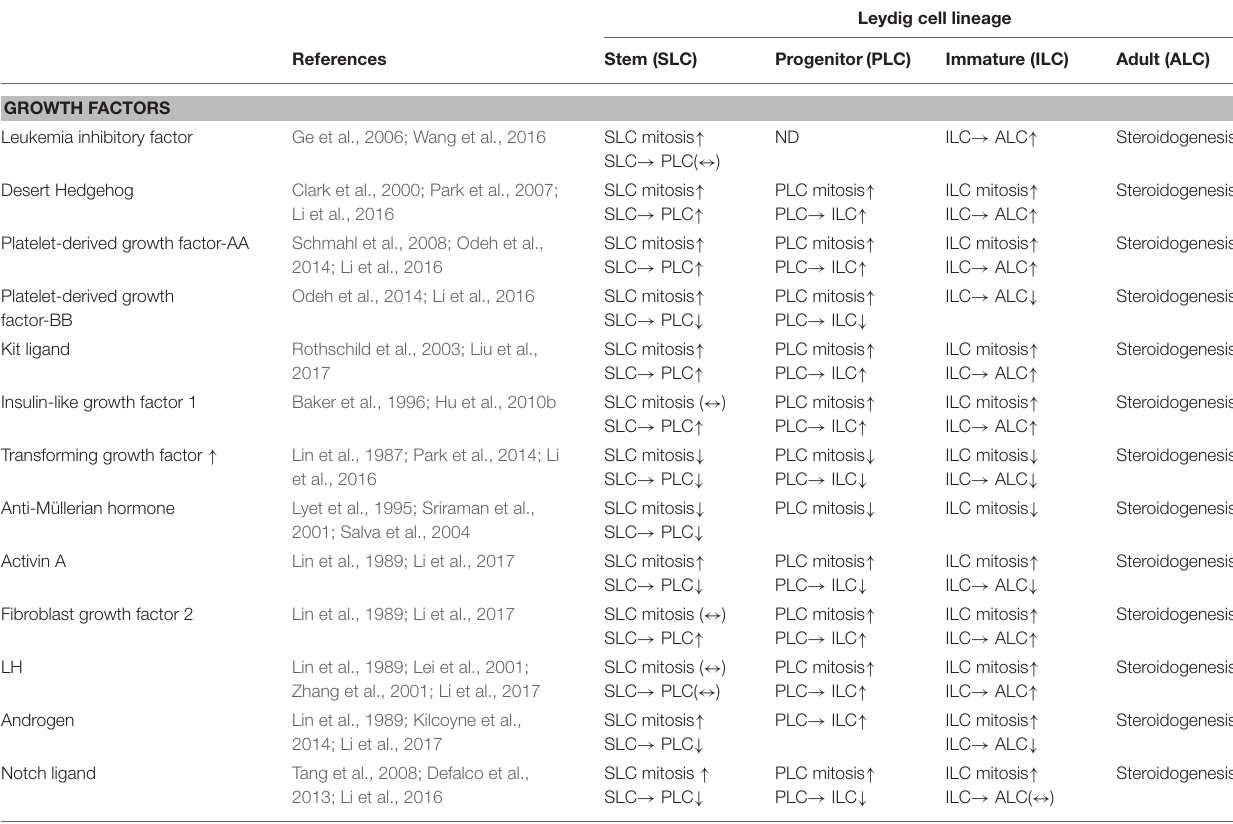
TABLE 2 | Regulatory factors and hormones for Leydig cell